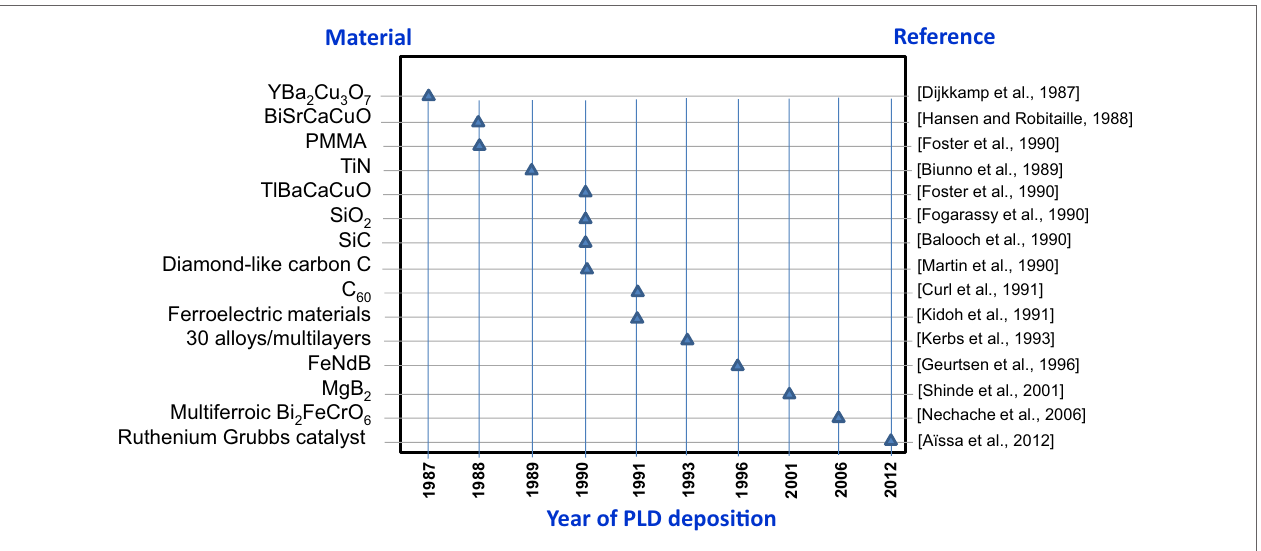
FiGURe 8 | List of the materials deposited for the first time by PLD after 1987